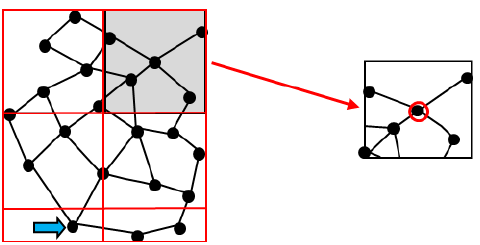
Figure 1. Stages of determining the sensor location. The first stage is seen on the left—division of the network into subareas. The second stage involving determination of the junction with the highest ranking position in the subarea is presented on the right. The blue arrow indicates the water supply point corresponding to the location of the first measurement point. Water 2020 , 12 , x FOR PEER REVIEW